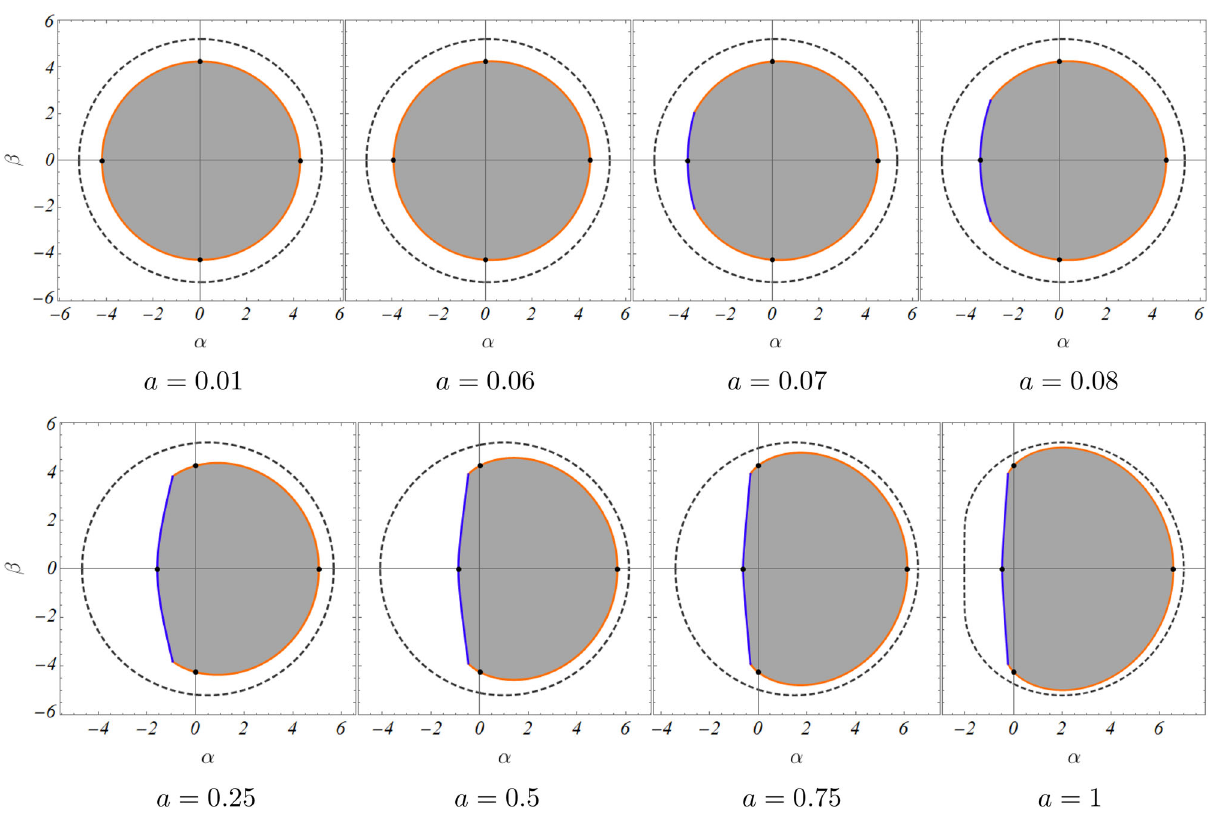
Fig. 5 Behavior of the spherical orbits in the vicinity of the shadow cusp for spin ( 1 ) ≈ 0 . 07. The parameter a ≥ a crit blue and orange lines represent the unstable spherical orbits associated with the two light rings, while their intersection point is denoted by A . The spherical orbits corresponding to the outer black ring become stable at the point B , and the stable branch is depicted with a red line. Point C is the stability turning point of the other family of spherical orbits associated with the wormhole throat. The observer inclination angle is θ = 90 0